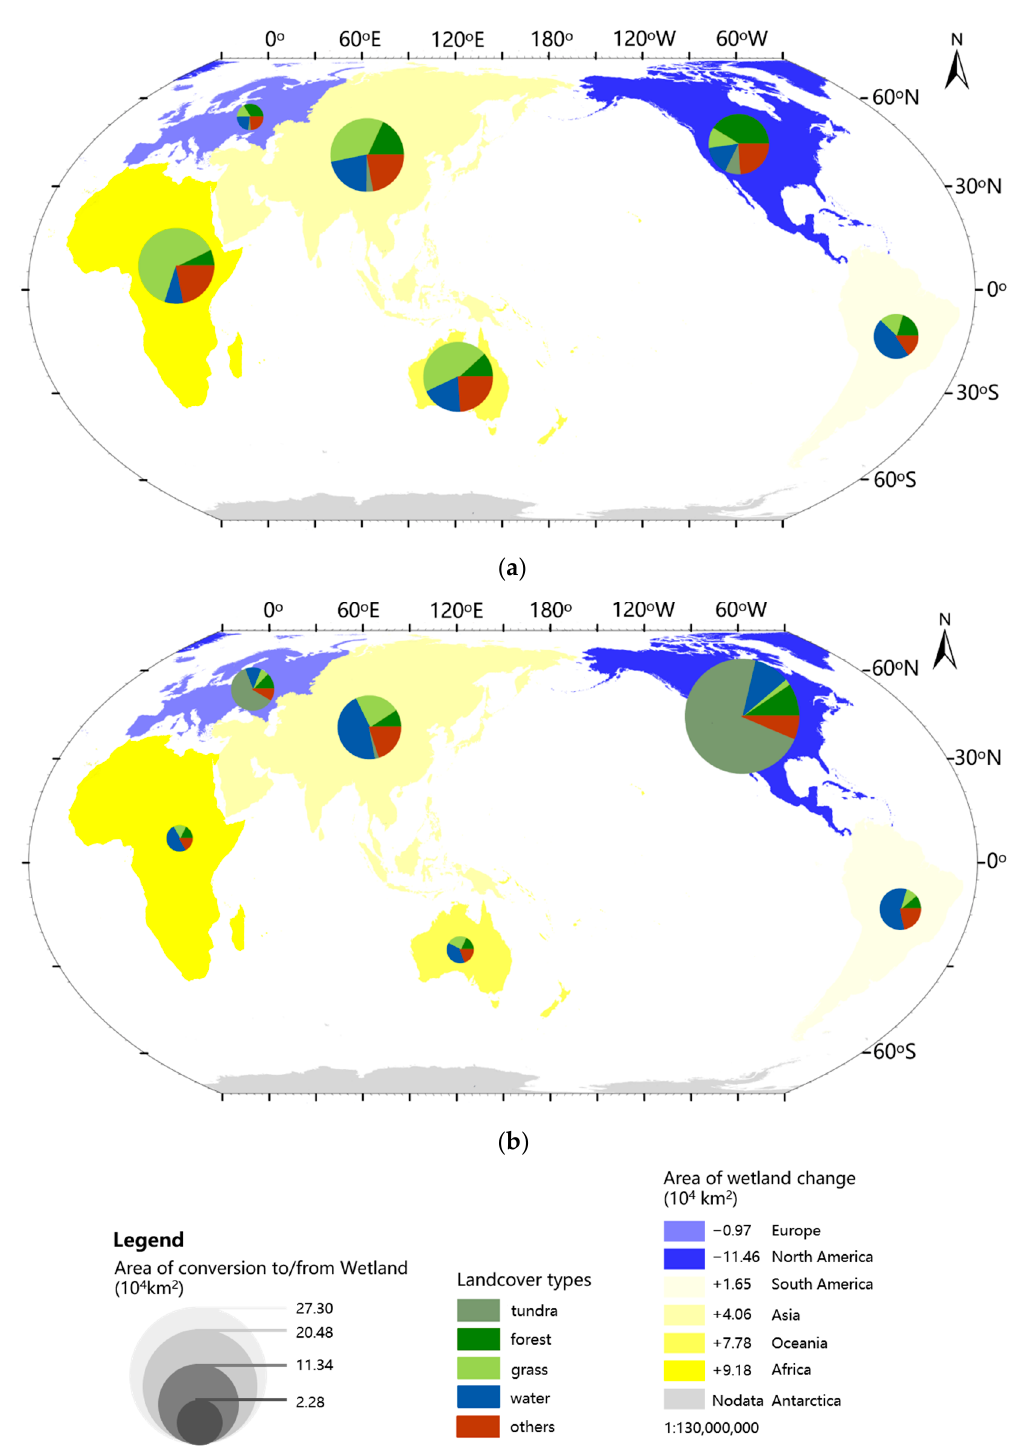
Figure 8. Wetlands conversions with other land cover types by continent, 2000–2010. ( a ). Wetlands converted from other land cover types by continent, 2000–2010. ( b ). Wetlands converted to other land cover types by continent, 2000–2010.